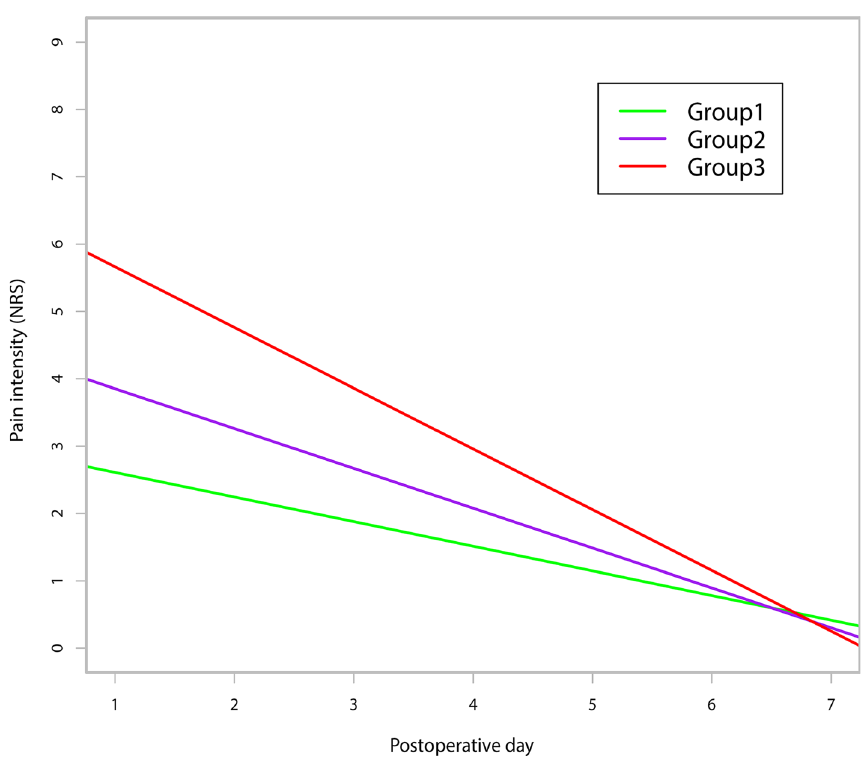
Figure 4. Results of the APSP trajectory analysis showing three different subgroups of patients. APSP Acute postsurgical